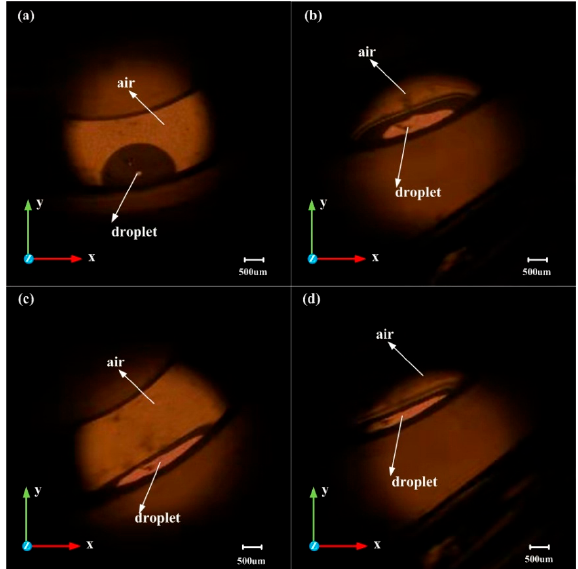
Figure 11. The shape of droplet in the XY plane: ( a ) at 42 m / s 2 , ( b ) at 242 m / s 2 , ( c ) at 438 m / s 2 , and ( d ) at 640 m / s 2 .